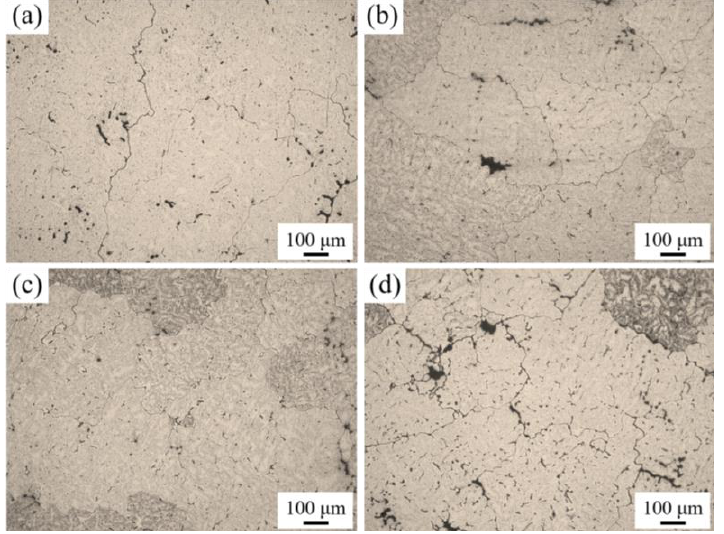
Figure 3. Optical micrographs of homogenized alloys with different Ce contents ( a ) AL1; ( b ) AL2; ( c ) AL3; and ( d ) AL4.